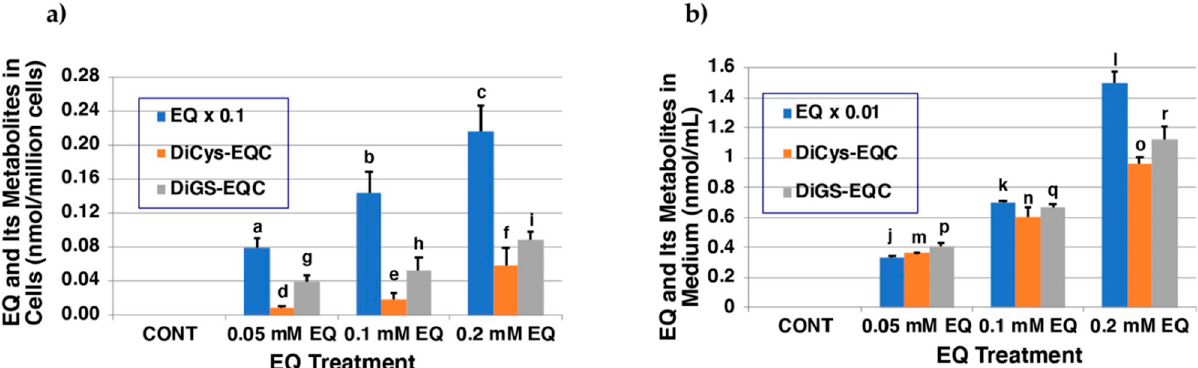
Figure 5 . Metabolism of EQ 1 in cells transfected with human tyrosinase yielding di-adducts of CySH and GSH ( a ) in the cells; ( b ) in the medium. The data are mean ± SD from triplicate dishes. Statistically significant differences: p < 0.05 (a–b; b–c; d–f; e–f; h–i), p < 0.01 (a–c; g–i; n–o), p < 0.001 (j–k; k–l; j–l; m–n; m–o; p–q; q–r; p–r). Non-significant differences: g–h ( p > 0.1); d–e ( p > 0.05). The statistical significance of the differences was determined by Student’s t -test (two-tailed).